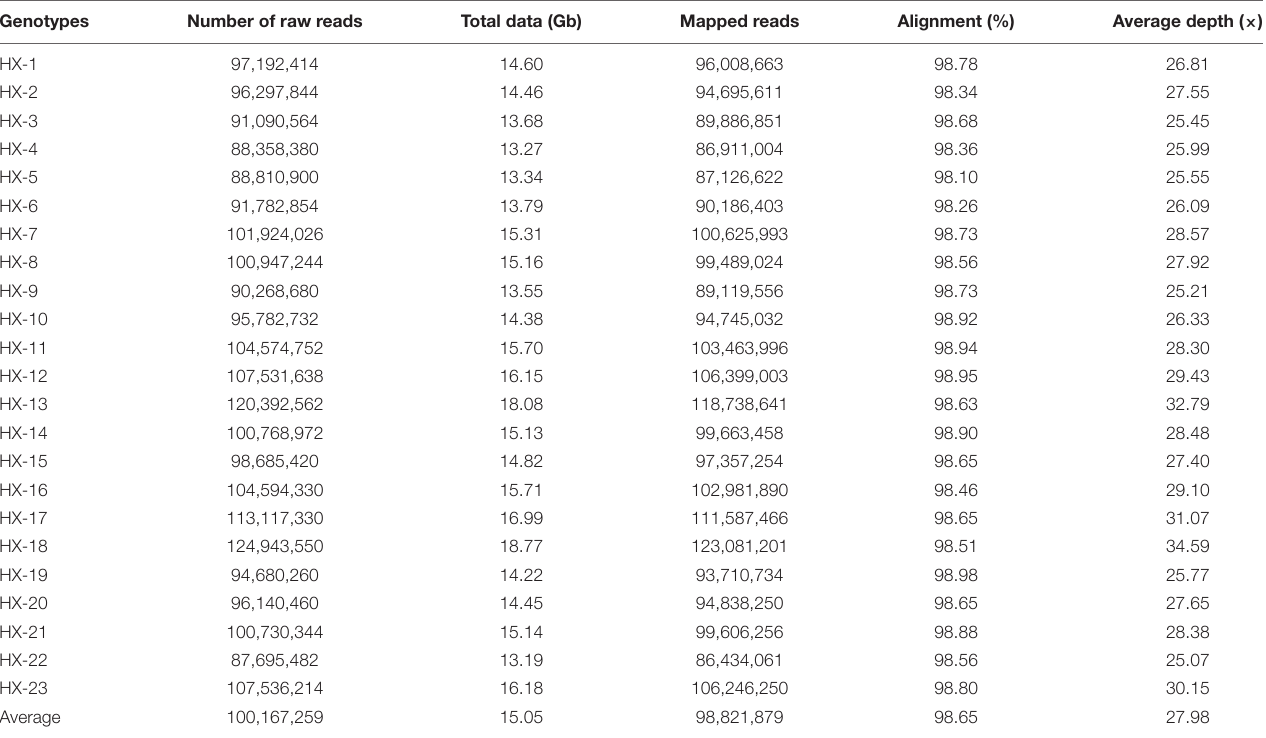
TABLE 1 | Statistics on whole-genome sequencing of 23 genotypes. Genotypes